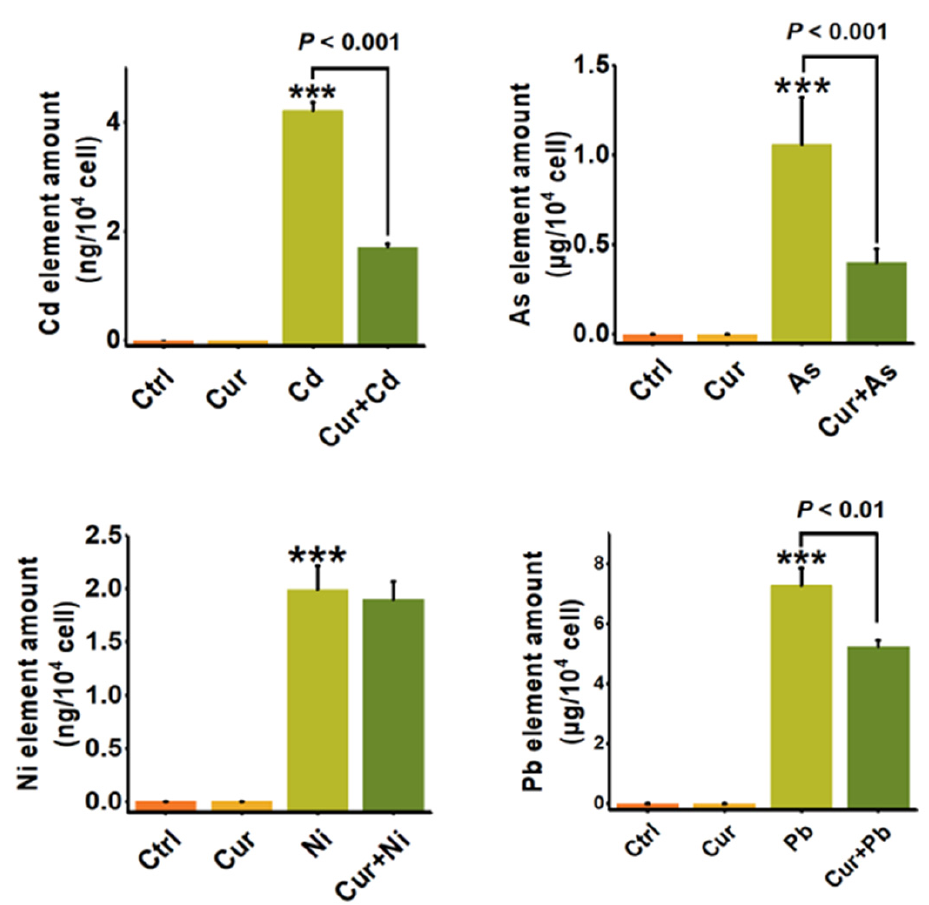
Figure 7. The bioaccumulation of heavy metals in HepG2 cells with or without curcumin ( n = 3). ICP-MS quantitively detected the cellular amounts of Cd, As, Ni and Pb with and without curcumin pre-treatments. The concentrations of curcumin and heavy metals were 20 µM for curcumin, 6 µM for Cd, 100 µM for As, 2 mM for Ni and 2.5 mM for Pb, separately. *** p < 0.001, compared to the untreated group.